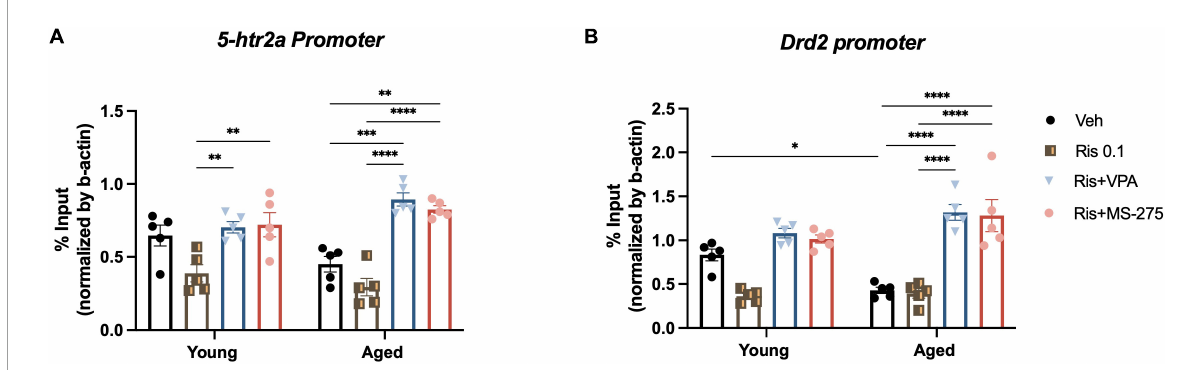
FIGURE4 Effects of histone deacetylase (HDAC) inhibitors on histone acetylation at the 5htr2a and Drd2 gene promoters in the striatum in young and aged mice. (A) No significant differences of H3K27ac binding at the 5htr2a promoter between young and aged group was found, but a significant increase in H3K27ac binding at the 5ht2a promoter in the striatum was found in aged and young mice co-treated with RIS and VPA or MS-275 compared to those treated with RIS alone. (B) H3K27ac binding at the Drd2 promoter was significantly decreased in aged mice as compared to young mice in Veh treated group. However, H3K27ac binding at the Drd2 promoter in the striatum was observed to be significantly increased in aged mice co-treated with RIS and HDAC inhibitors VPA or MS-275 when compared to those treated with Veh alone. Data are presented as mean ± SEM, ( n = 5). ∗ p < 0.05, ∗∗ p < 0.01, ∗∗∗ p < 0.001, ∗∗∗∗ p <